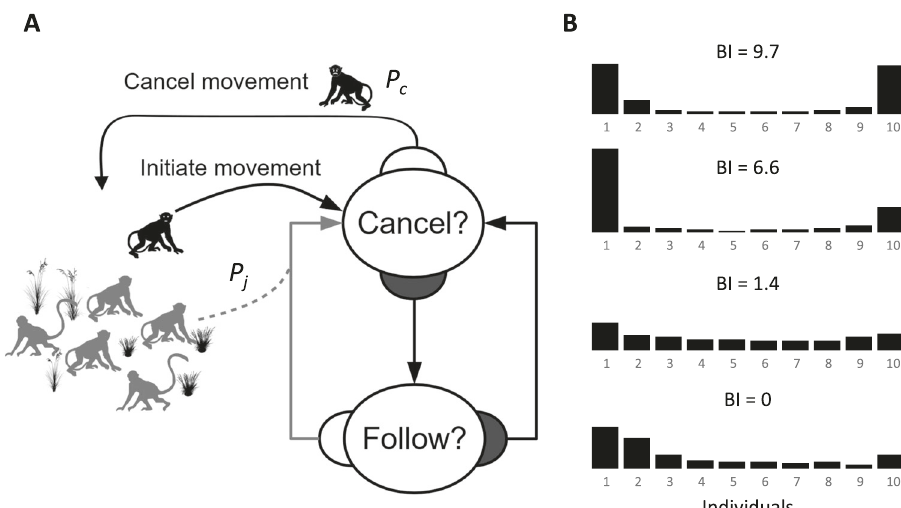
Fig. 1 Flow diagram of the model and examples of bimodality index. A Flow diagram of the model. In the decision nodes, dark-grey = no; white = yes. Initiator (black) starts a movement by departing from the group, and other monkeys (grey) can either join the movement or remain with the rest of the group. B Four examples of bimodality index (BI) for the probability distribution of the number of individuals following a given initiation. Higher index values indicate higher degrees of bimodality, and a BI of zero means that some of the prerequisites are not met (see methods). The U-shaped response arises because initiations typically either fail when they are not joined, or succeed when joined by all group members, while responses in between these extremes are